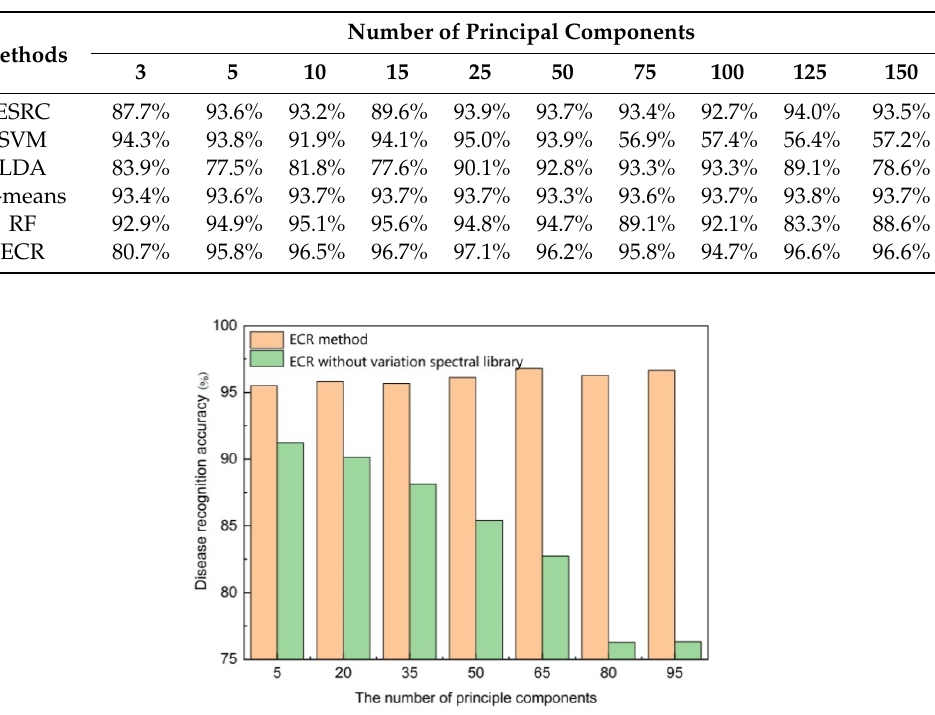
Figure 4. Comparison results of the ECR method with and without variation spectral library.